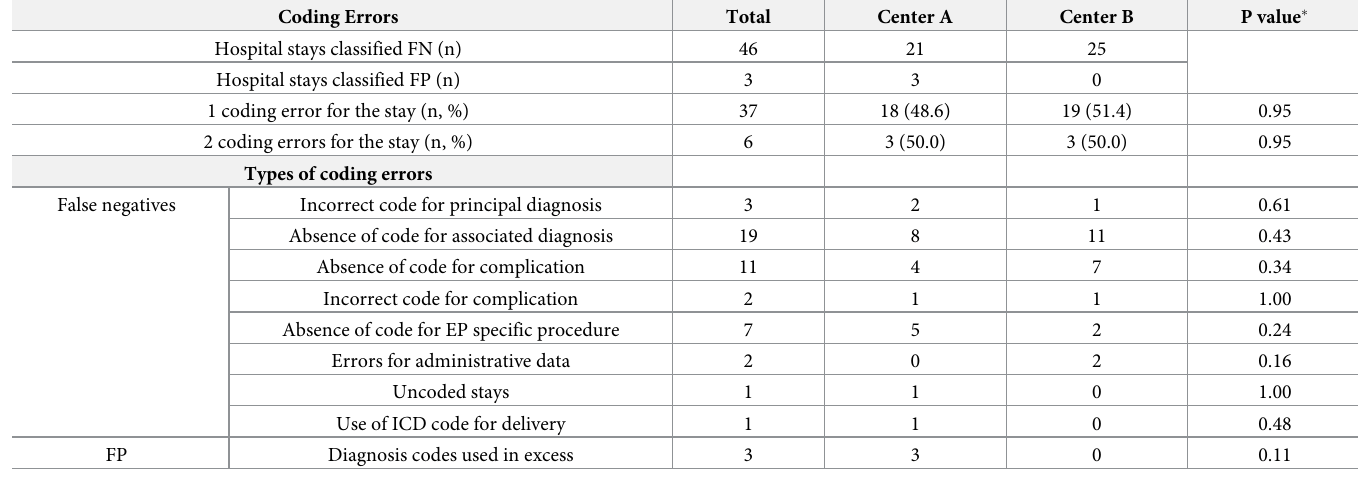
Table 4. Description of coding errors in HDD for the 43 hospital stays classified as false positives (FP) and false negatives